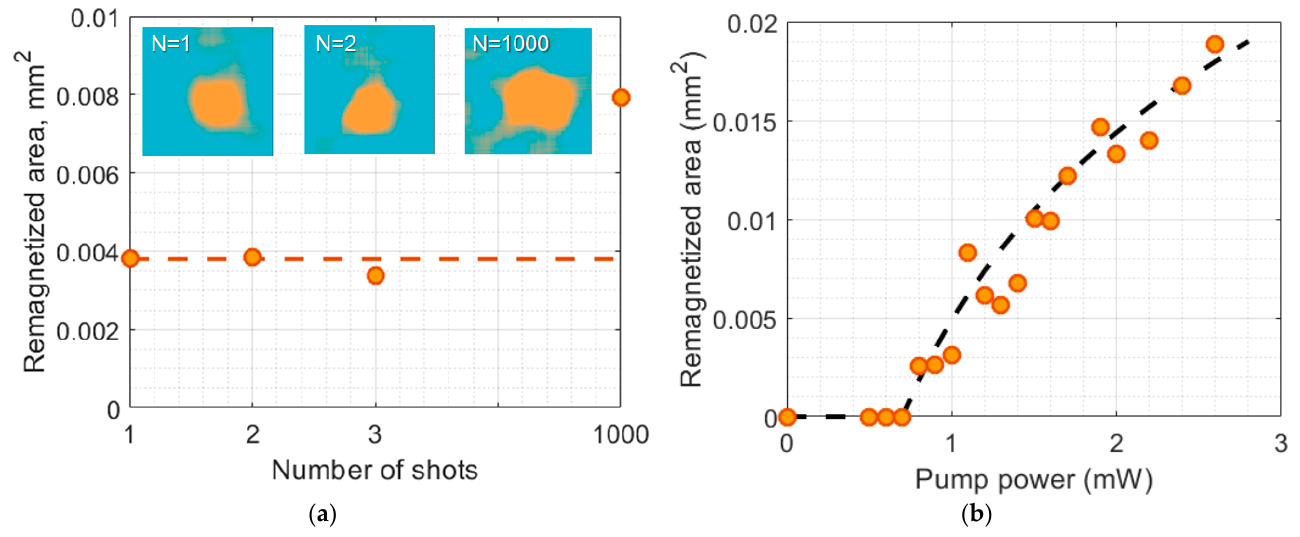
Figure 2. Thermal mechanism of magnetization switching in the GdFeCo film with in-plane magnetic anisotropy. ( a ) The dependence of the remagnetized area on the number of femtosecond laser shots. The insets (false-color) show the magnetization state after the action of the train of femtosecond pulses containing N = 1, 2 and 1000 shots. ( b ) The dependence of the remagnetized area on the power of the femtosecond laser pulse trains.